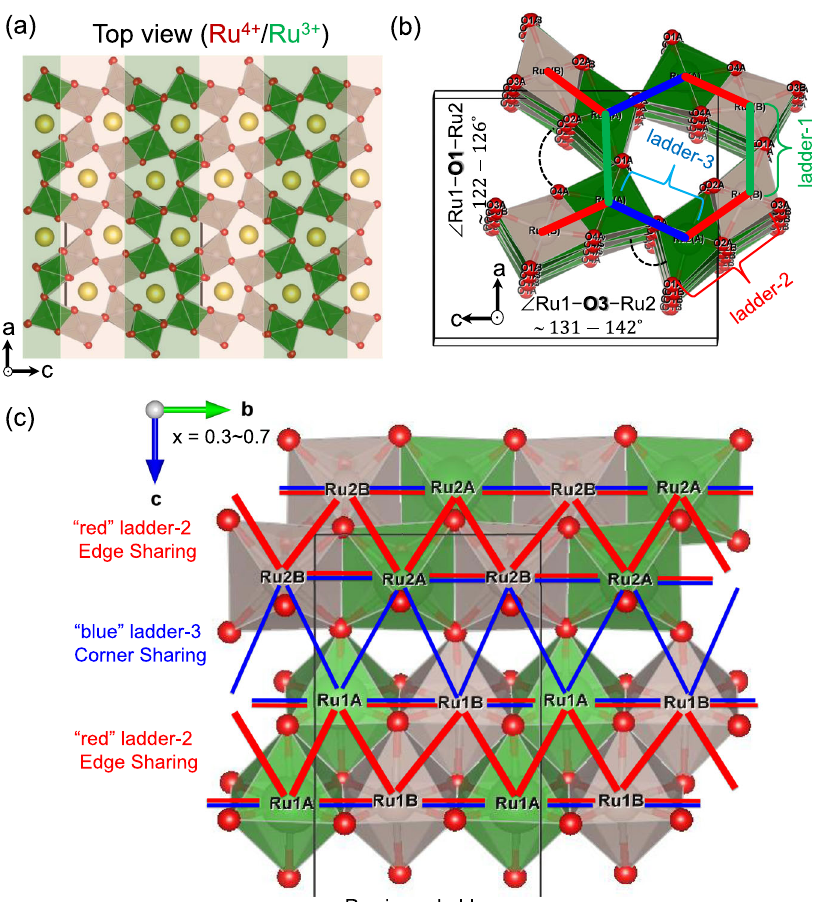
Fig. 6 Crystal structure of the tunnel compound NaRu 2 O 4 . a Top view of the low-temperature structure. b Illustration of different types of zigzag ladders: “ red ” ladders with edge-sharing RuO “ green ” and “ blue ” ladders with corner-sharing octahedra. c The detailed structure of corner-sharing and 6 octahedra; edge-sharing